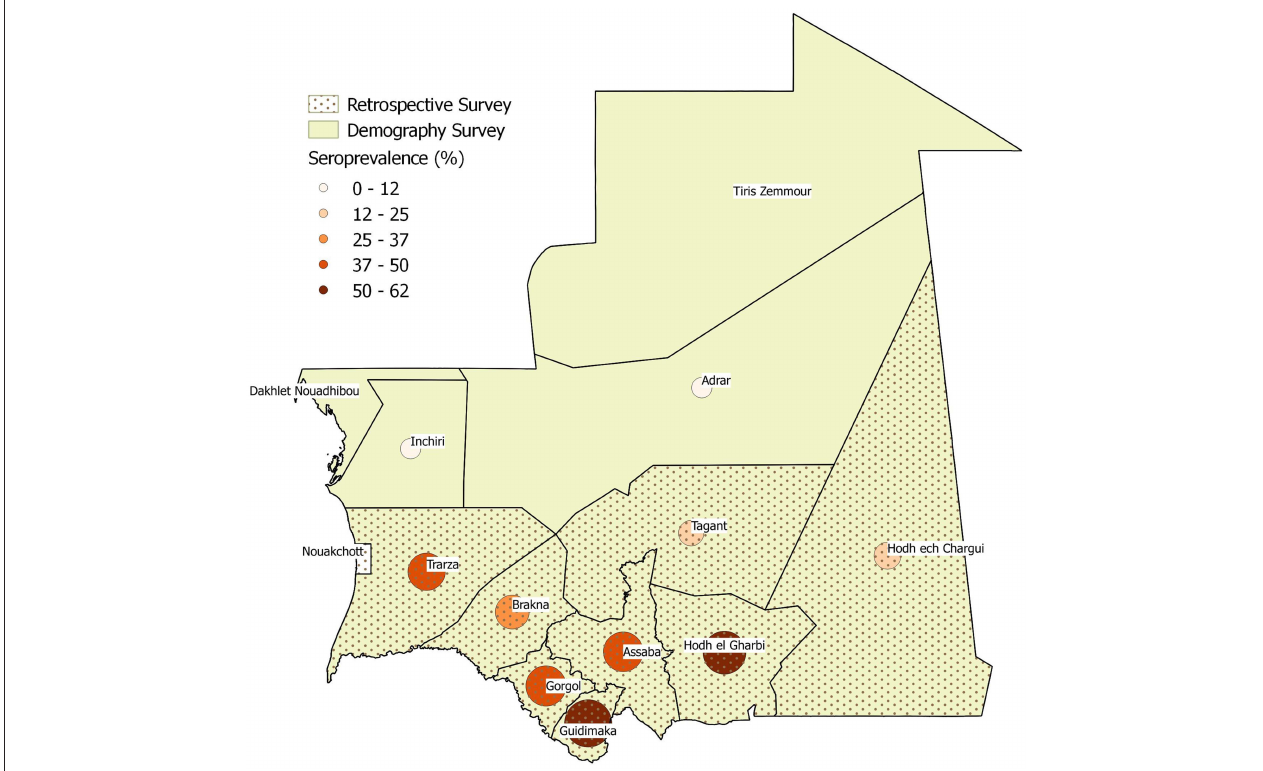
FIGURE 1 | Wilayas included in the demographic (color), impact (dotted pattern) and seroprevalence (circles of darker color and increasing size by positive percentage) surveys.